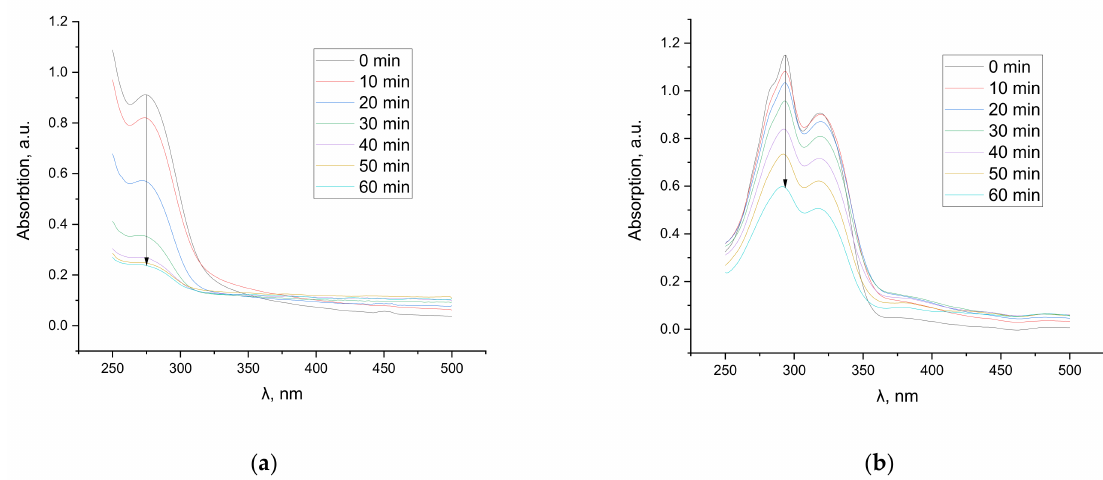
Figure 3. Hydrolysis of ligand 1 for 1 h ( a ) at pH = 5; ( b ) at pH = 7.